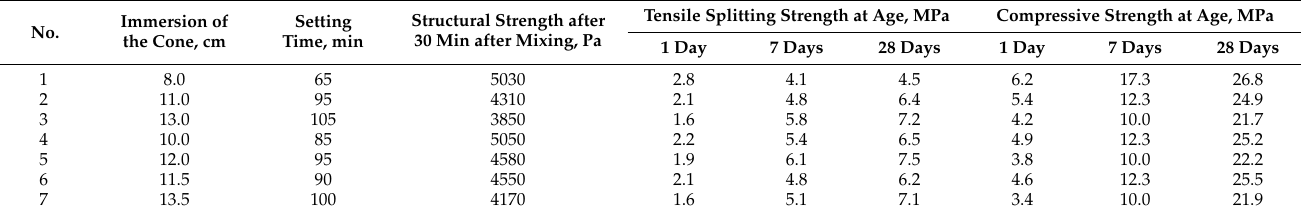
Table 4. Results of influence of RPP on the properties of concrete.